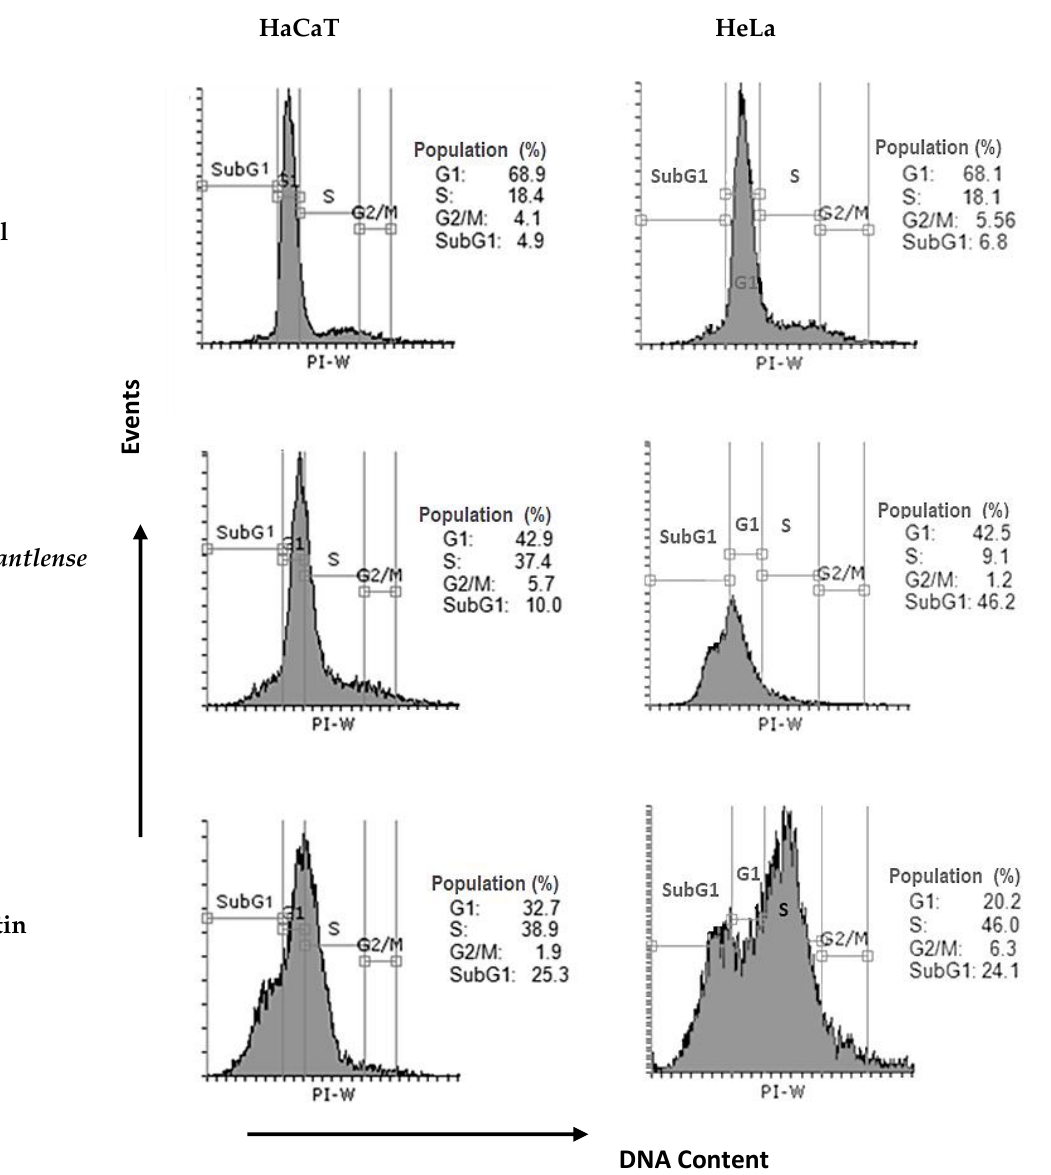
Figure 2. Effects of S. chinantlense extract or cisplatin at the IC 50 value on cell cycle distribution in HeLa and HaCaT cells. Histograms represent flow cytometric analysis of untreated control, S. chinantlense extract-treated, and cisplatin-treated HeLa and HaCaT cells. The X -axis represents the intensity of PI staining, which is directly proportional to the amount of DNA in cells, and the Y -axis represents cell number.